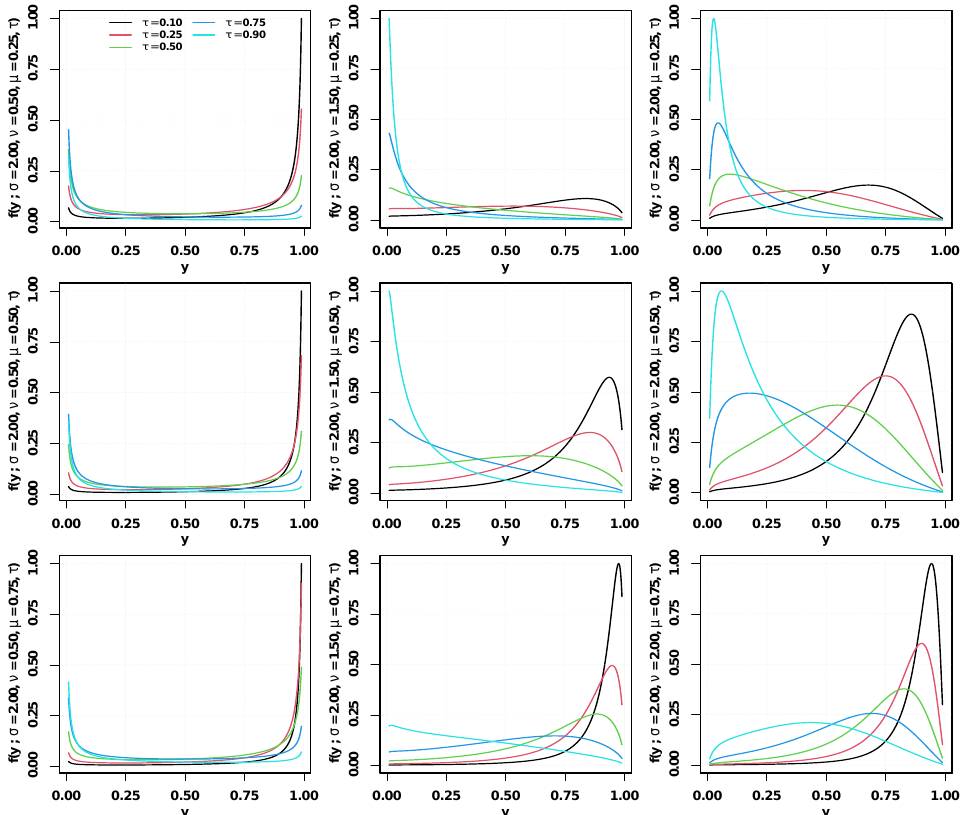
Figure 4. Plots of the UWMOQ PDF for the indicated values of µ , ν , τ , and σ = ς =